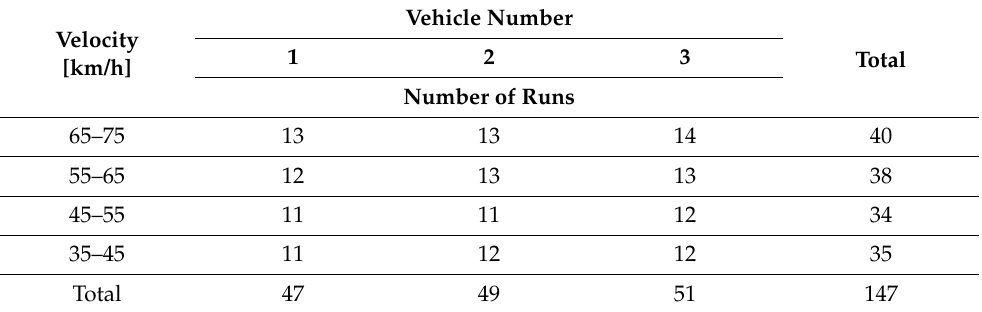
Table 2. Plan of the calibration